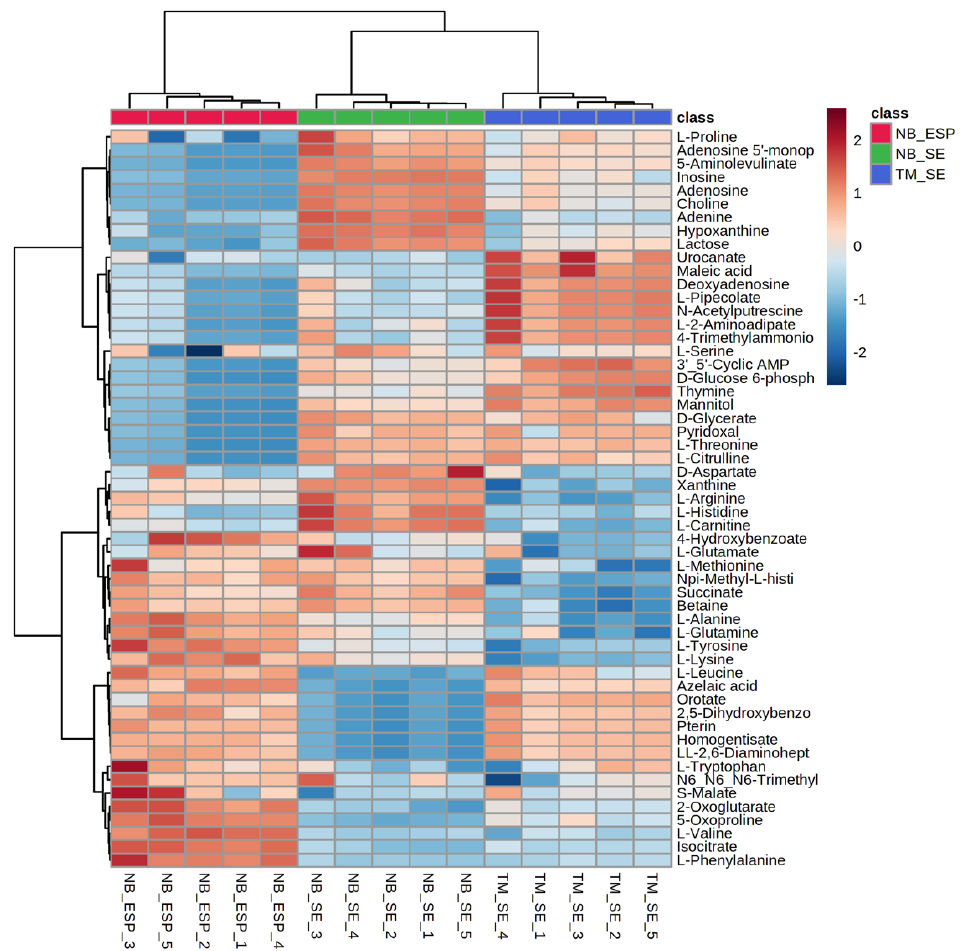
Figure 5. Hierarchical clustering analysis (HCA) of the three samples (the somatic extract of infective third-stage larvae (L3) of N. brasiliensis (NB_SE), the excretory / secretory products (ESP) of N. brasiliensis L3 (NB_ESP), and the somatic extract of T. muris embryonated eggs (TM_SE)) showing discrimination between the sample types and di ff erential abundances of 55 polar metabolites. Each column represents sample groups with their replicates, and each row represents the expression profile of a metabolite across sample groups. The scale bar represents the normalised intensity of metabolites, where blue indicates a decrease / low and red an increase / high. Media (QC_Media) and pooled quality control (QC_P) values were excluded from the analysis, as they were subtracted from the samples.